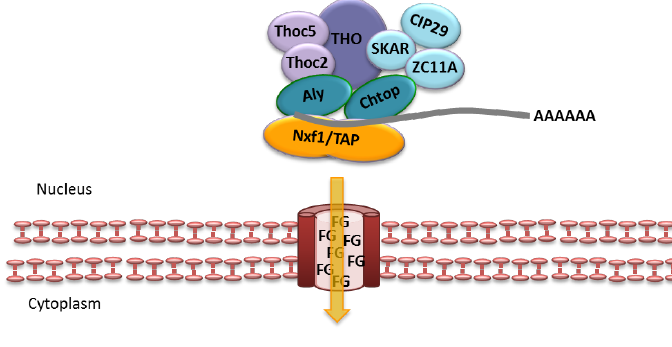
Figure 4. Handover of mRNA from TREX onto Nxf1/TAP and translocation through the nuclear pore complex